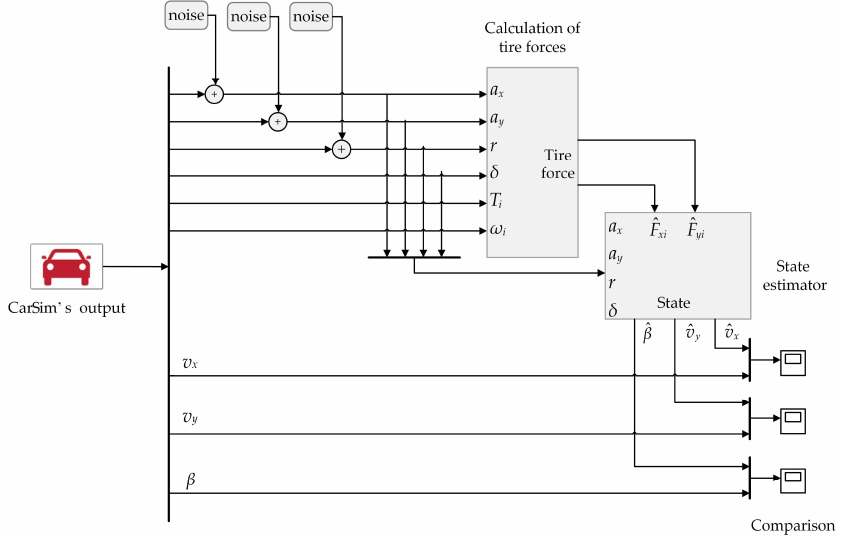
Figure 8. Verification structure for robust estimation